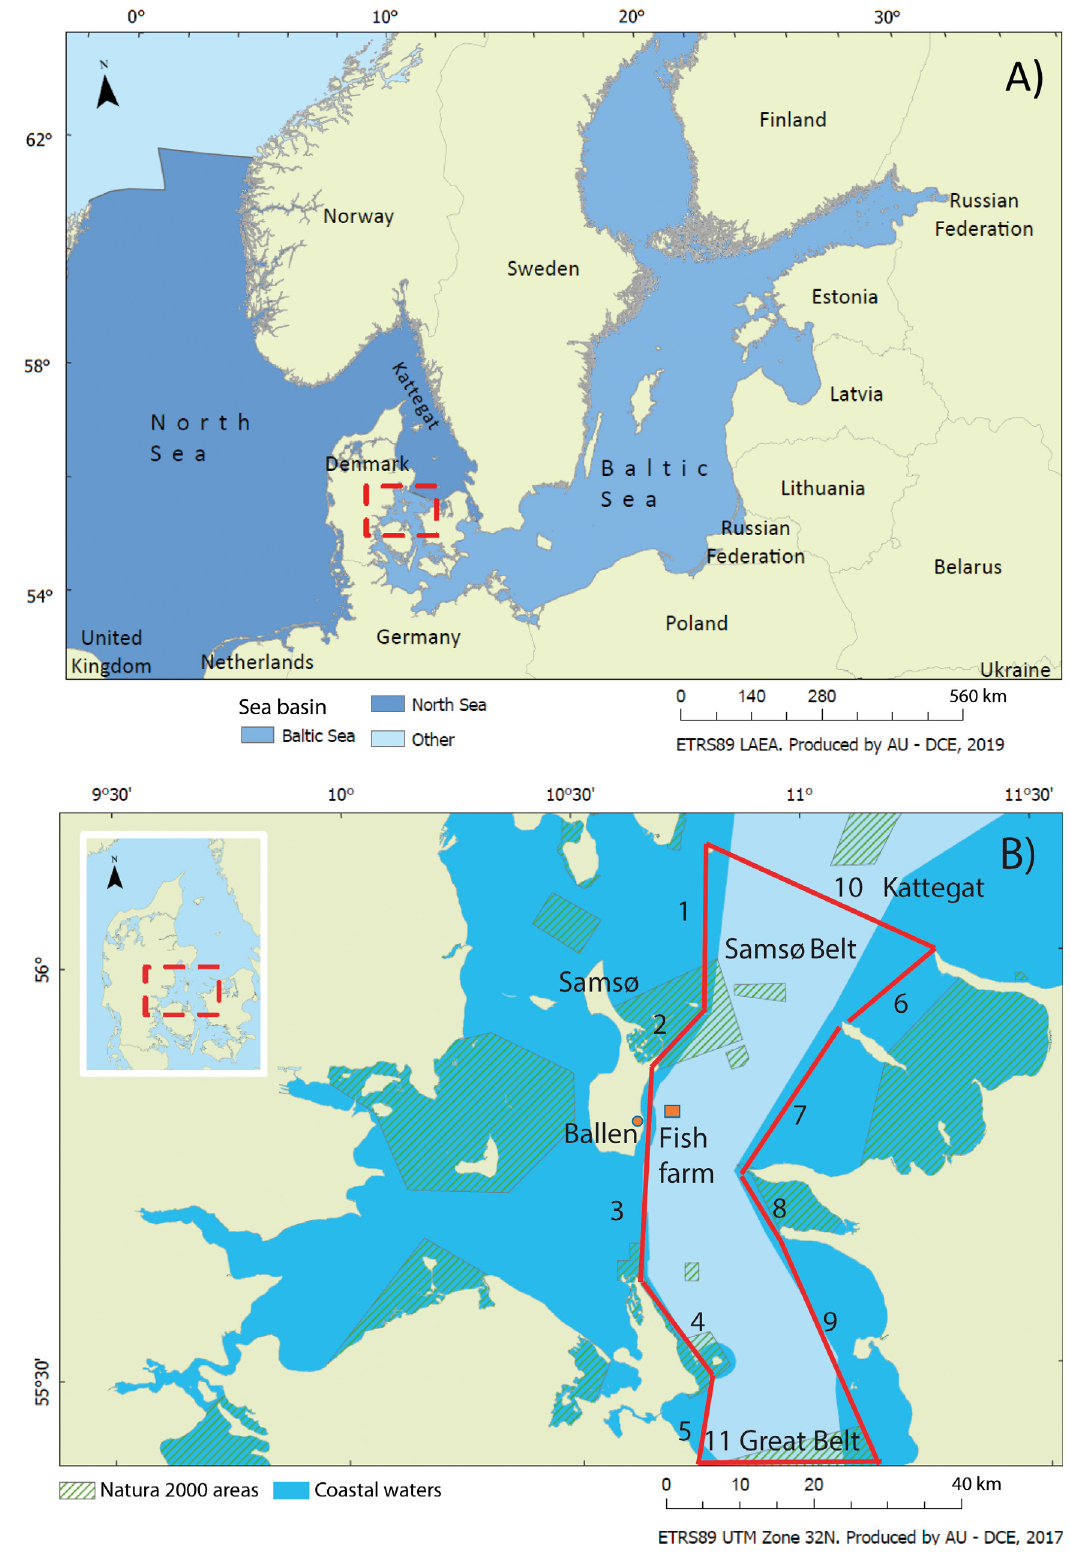
Fig. 2. (A) Study site (outlined in red) in the Danish transition area between the North Sea and the Baltic Sea. (B) Location of the fish farm in the open waters of the Samsø Belt area and the neighboring EU Water Framework Directive (WFD) coastal waters and Natura 2000 areas. The 11 transects for estimations of nutrient transport are shown as red lines with numbers. The dark blue area indicates the administrative coastal areas protected by the WFD and the light blue area is defined as open